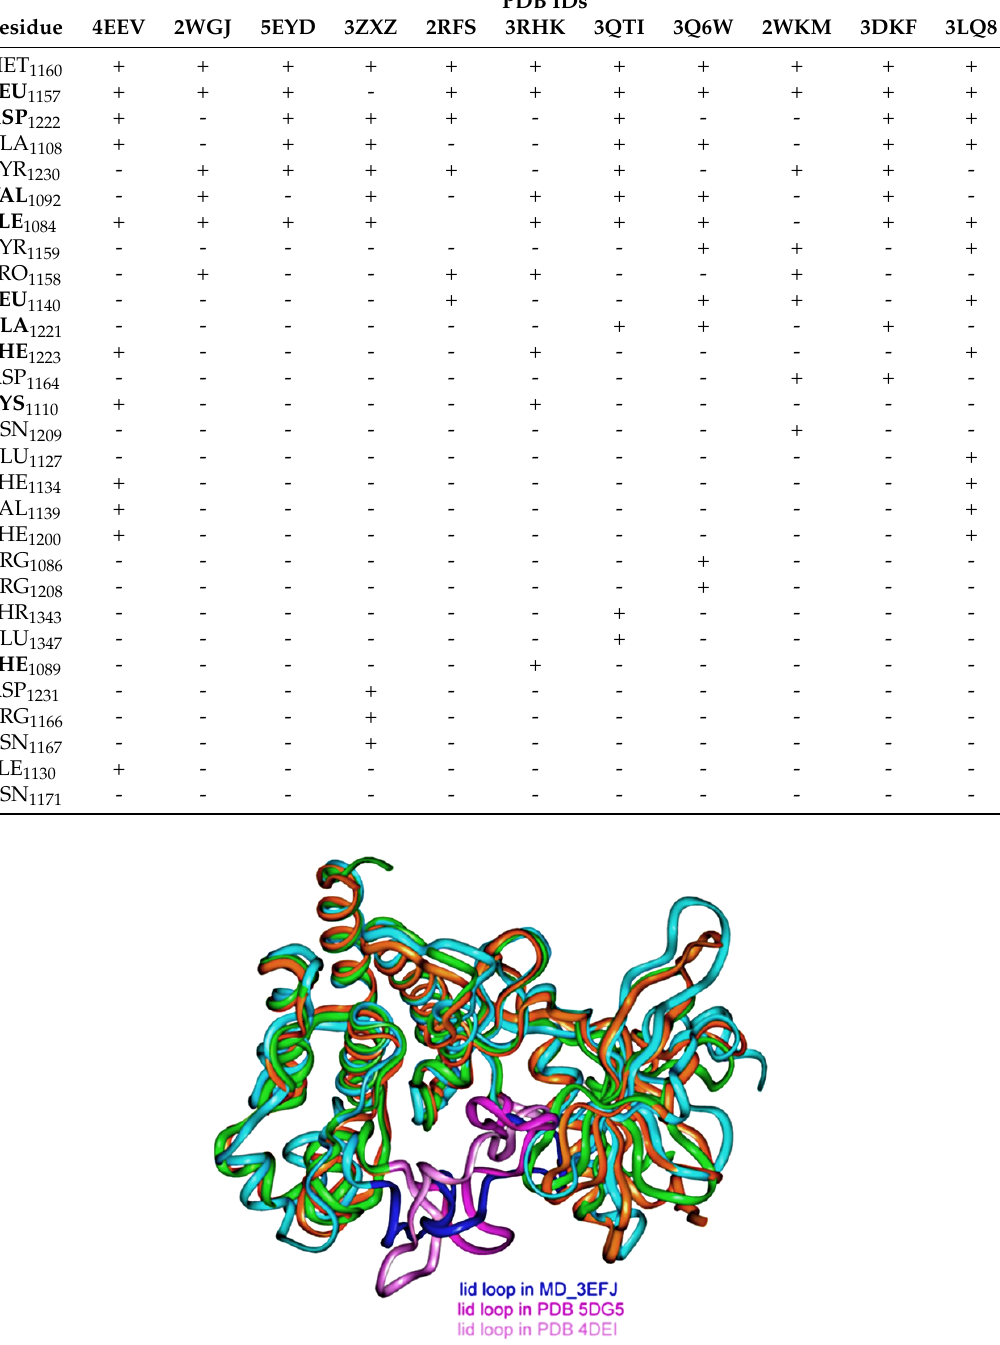
Figure 6. Differences for the lid DFG loop between selected PDB structures and our MD-refined MD_3EFJ conformations. The proteins are depicted from their C α ribbon-like